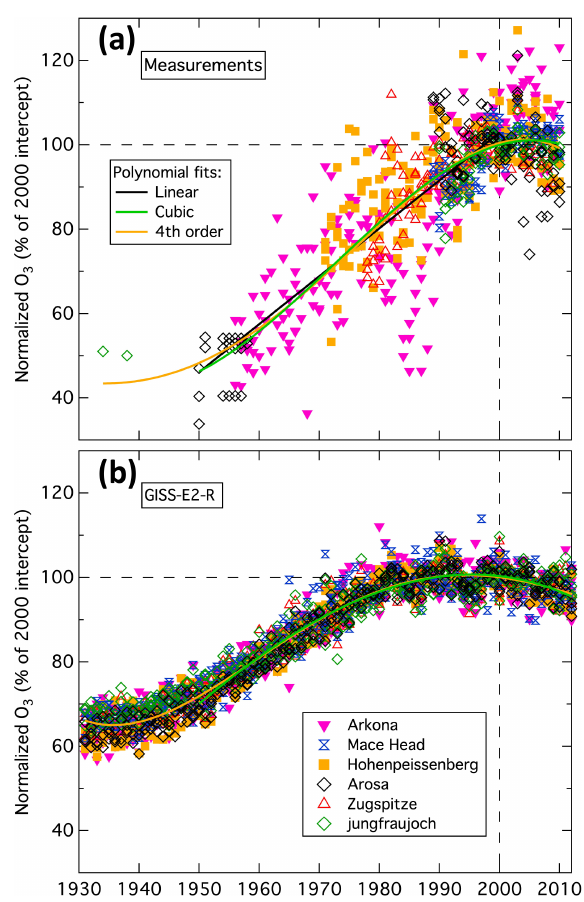
Figure 2. Normalized, seasonal mean ozone measured (a) and sim- ulated (b) at the six baseline representative European sites consid- ered by Parrish et al. (2014). The simulations are from the GISS- E2-R model. Each graph includes cubic (beginning in 1950 – green curve) and fourth-order polynomial (gold curve) fits to all seasonal means; (a) also includes a linear fit (1950–2000 – black